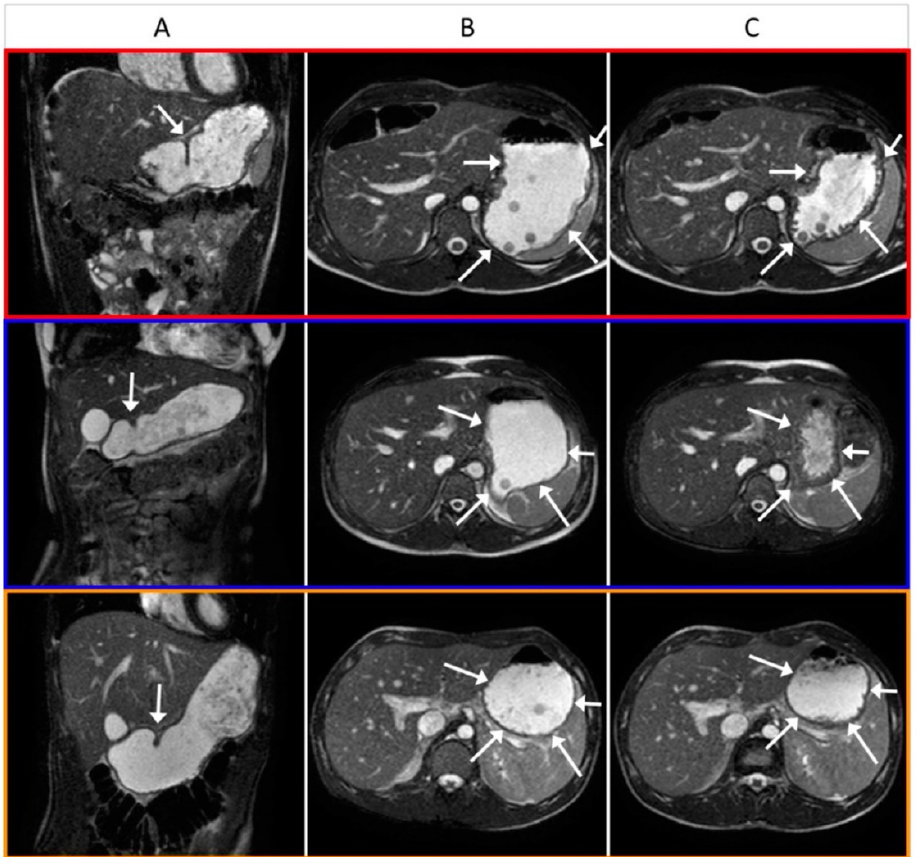
Figure 4. Magnetic resonance (MR) images of the stomach from representative participants. Red outlined images from an HV, blue from a DC, and orange from a DG patient. Column A: A coronal slice through the stomach taken 15 min after ingestion; white arrow shows antral contraction in wall. Column B: An axial slice through the stomach taken immediately after ingestion; white arrows highlight the thin “distended” stomach wall. Column C: An axial slice through the stomach taken 90 min after ingestion; white arrows highlight the thicker stomach wall for the red and blue images after much of the meal has emptied in these subjects, whilst the orange image shows little change in volume or wall thickness compared to the B image, as little has emptied from the stomach.